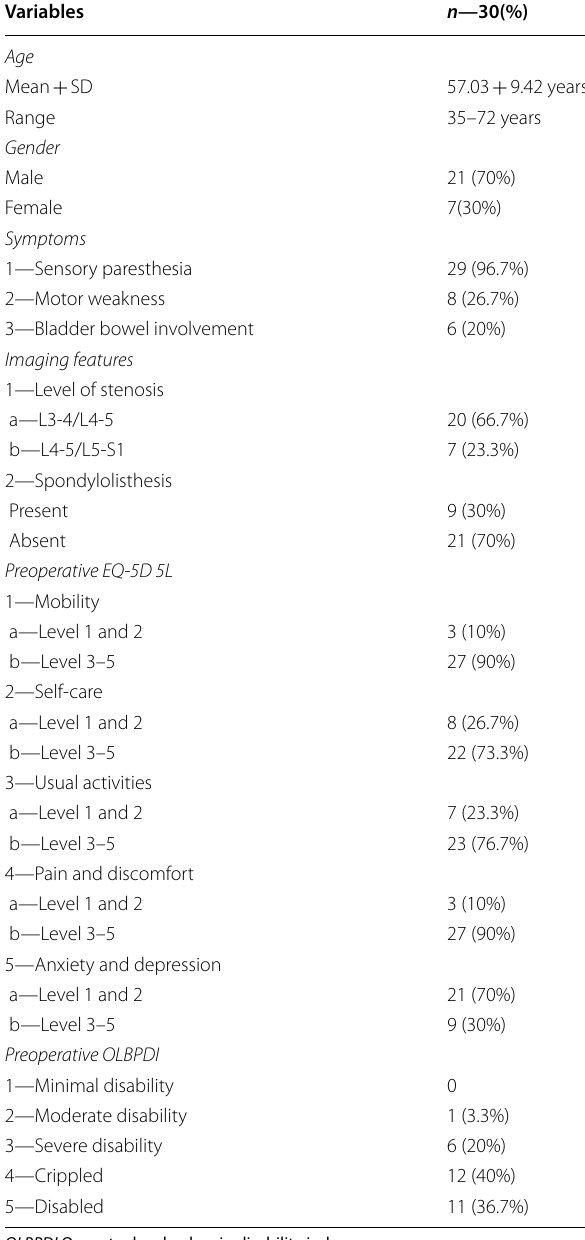
Table 1 Characteristics of the study